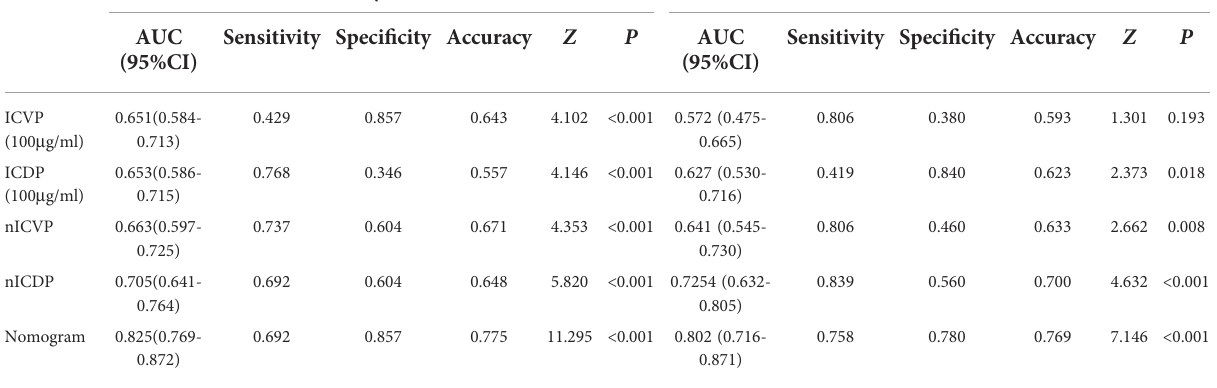
TABLE 5 ROC analyses of ICs and the developed nomogram. Variable